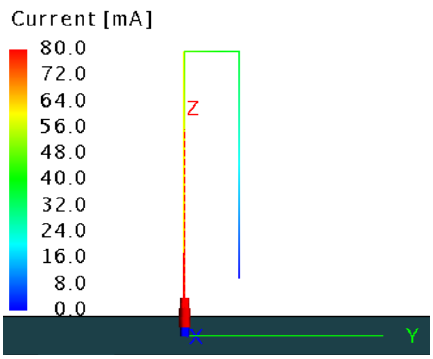
Figure 4. Segment currents of SF model